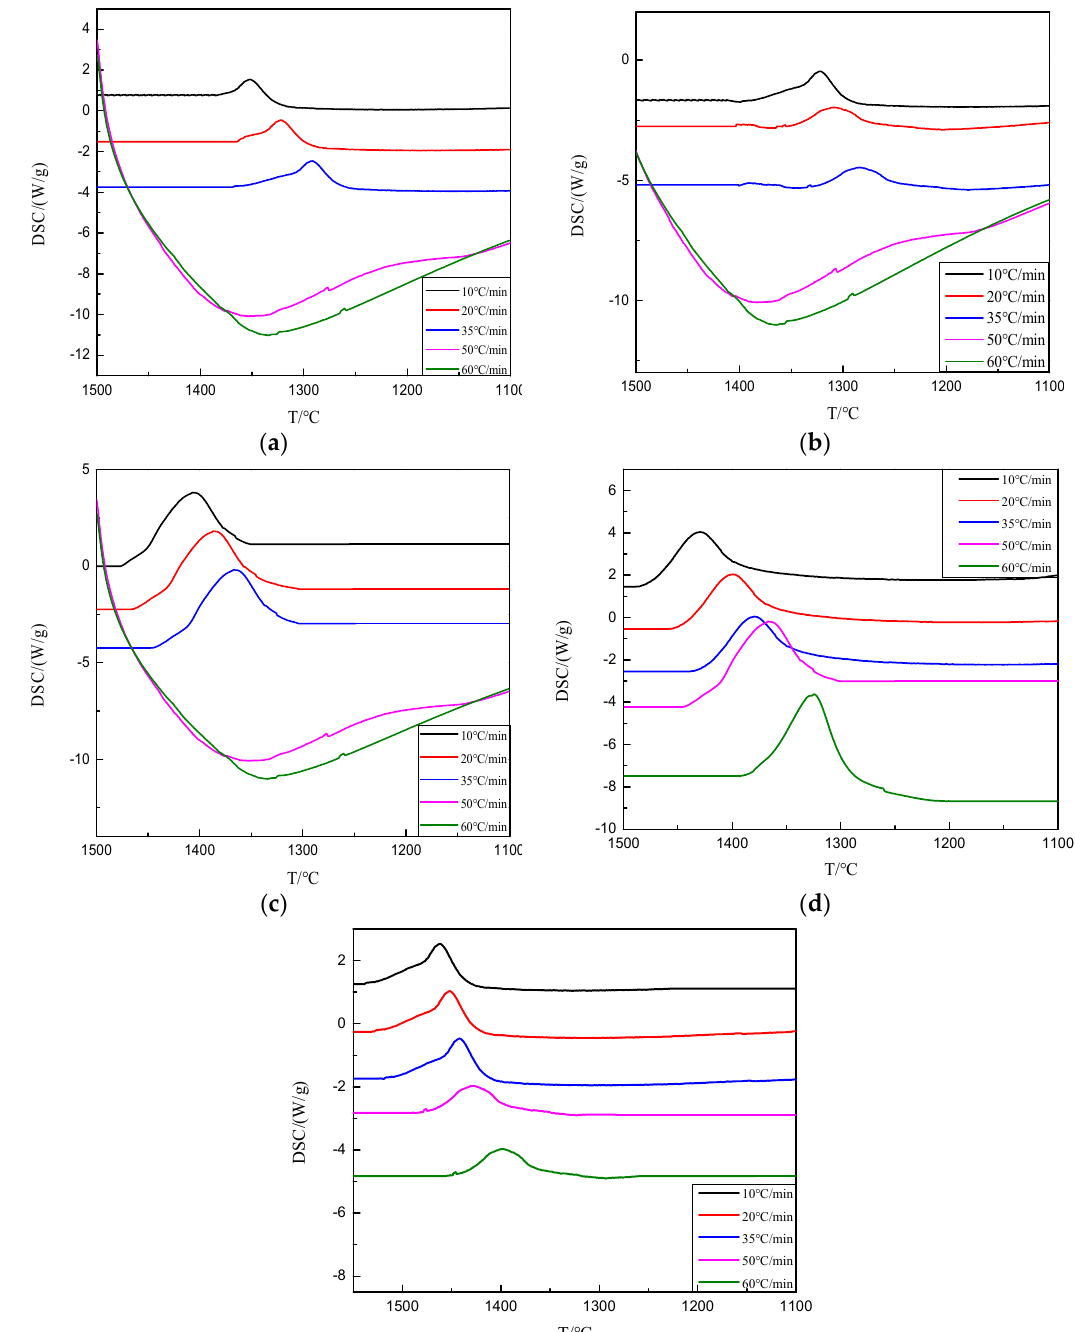
Figure 8. The DSC cooling curves of modified BFS with different basicities. ( a ) R = 0.8; ( b ) R = 0.9; ( c ) R = 1.0; ( d ) R = 1.1; ( e ) R = 1.2. By drawing ln( β / T p2 )~10 4 / T p , the crystallization activation energy could be obtained by calculating Table 4. Crystallization temperature of modified BFS/°C. the straight slope − E / R , which can be obtained by linear fitting for each value